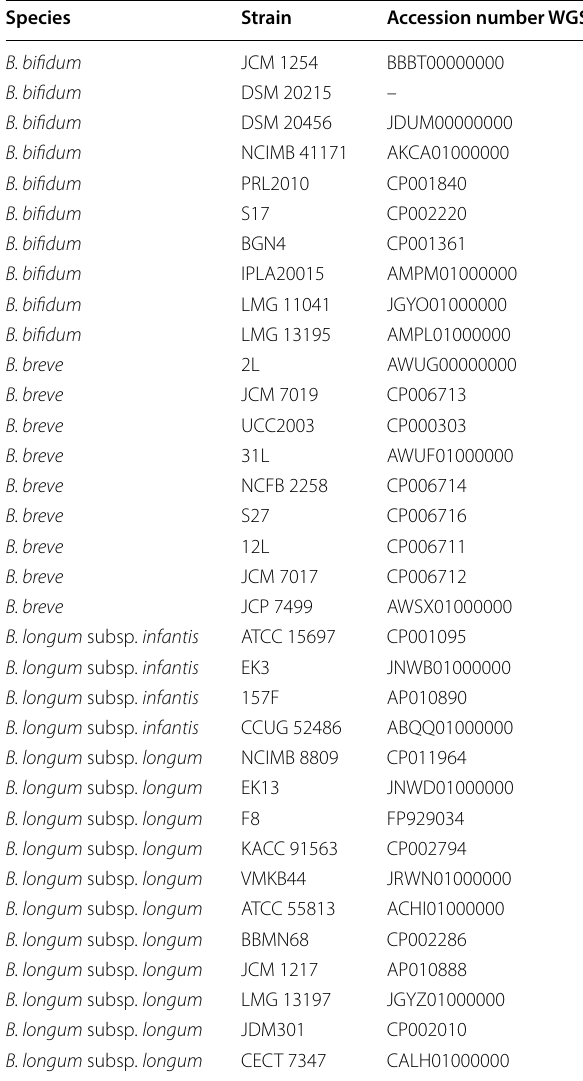
Table 1 Bifidobacterial strains used for comparative analyses